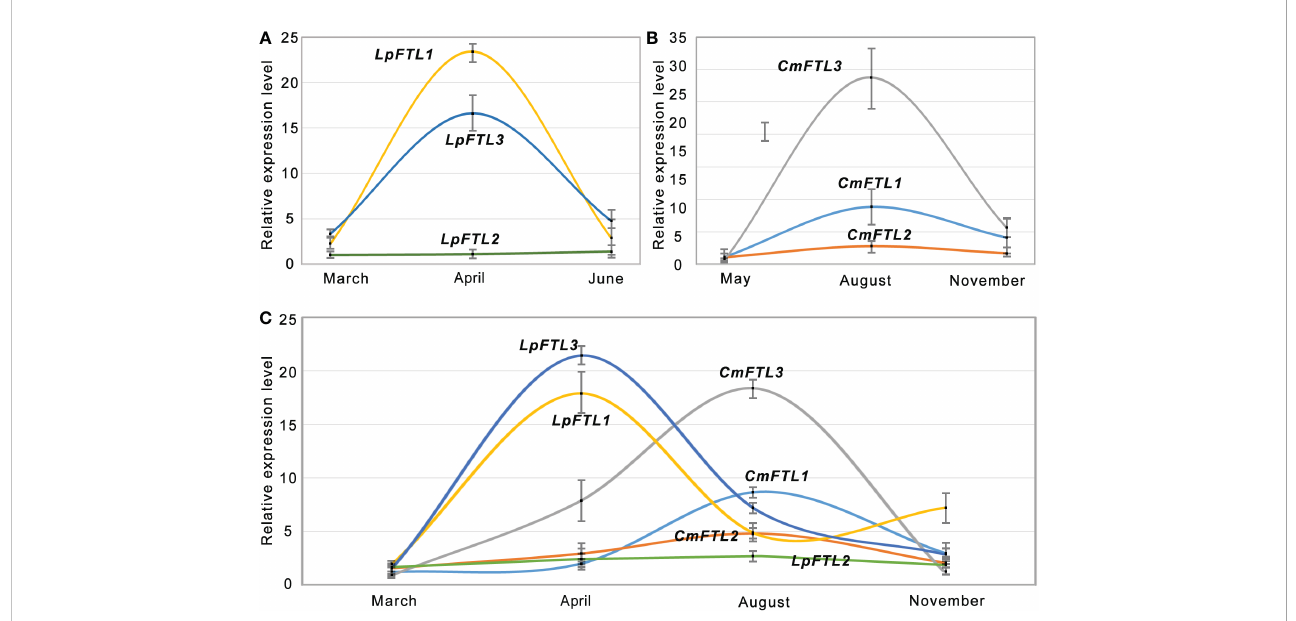
FIGURE 3 qRT-PCR veri fi cation of FTL genes. qRT-PCR analysis of LpFTL1 , LpFTL2 , and LpFTL3 in L. paludosum (A) , CmFTL1 , CmFTL2 , and CmFTL3 in C. morifolium (B) and six FTLs in C. morifolium × L. paludosum (C)